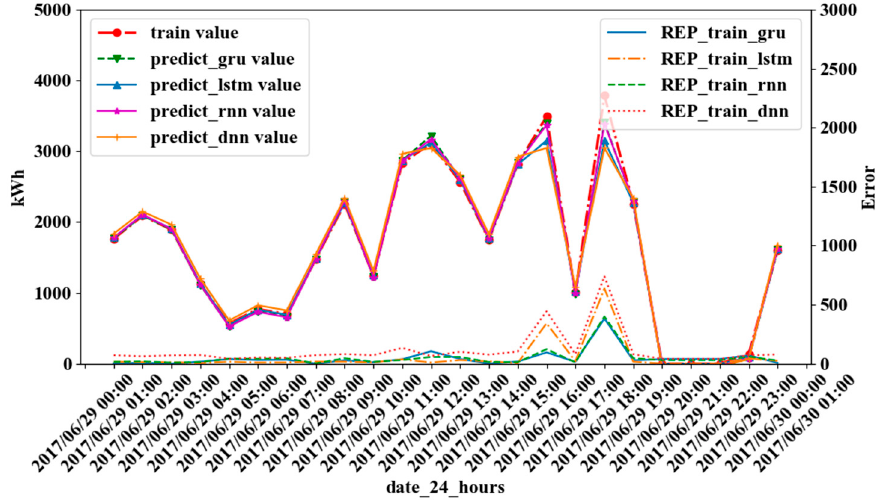
Figure 8. Predictions and REP of the training stage.